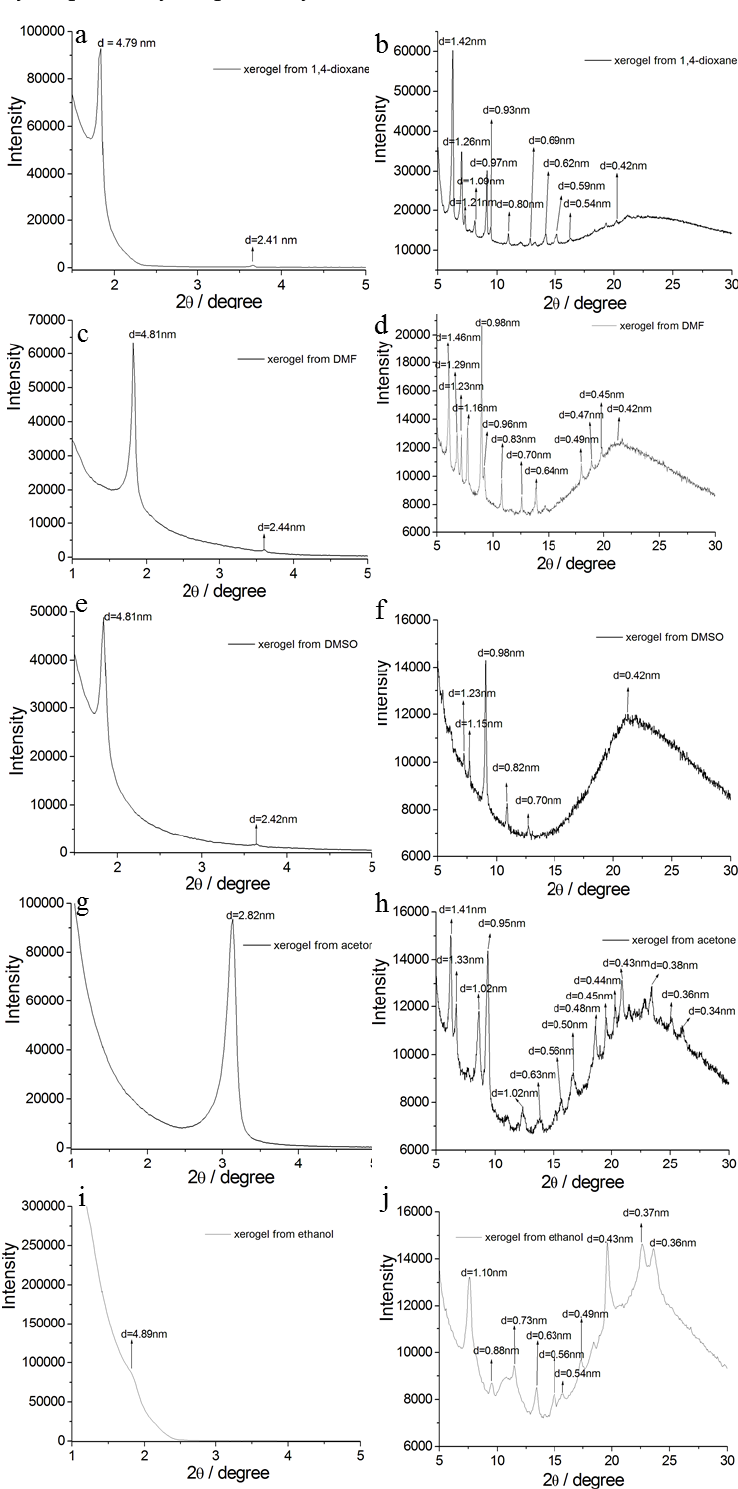
Figure 6. XRD patterns of xerogel 1 formed in different solvents. ( a , b ) dioxane, ( c , d ) DMF, ( e , f ) DMSO, ( g , h ), acetone, ( i , j ) ethanol.